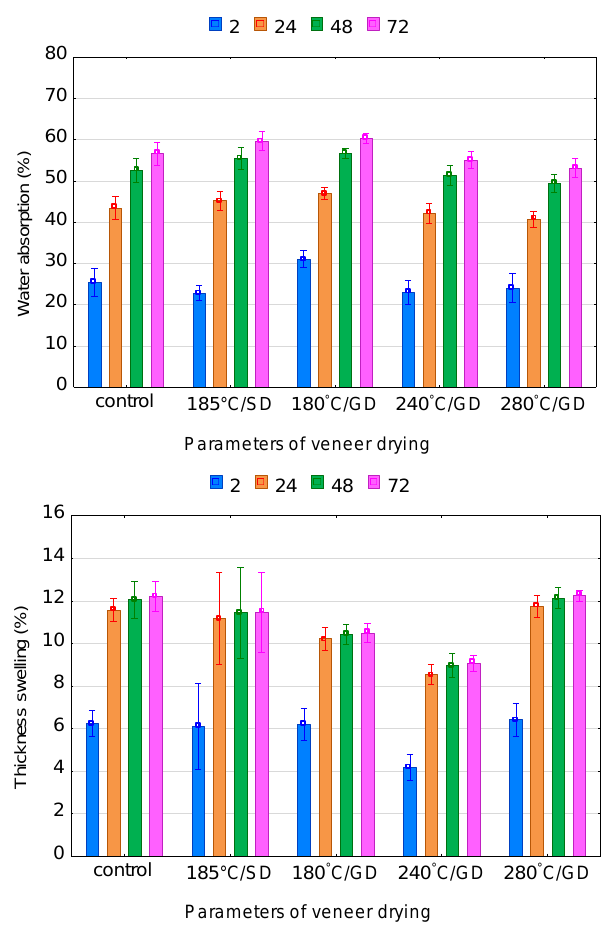
Figure 3. Water absorption and thickness swelling of urea–formaldehyde (UF) plywood samples.